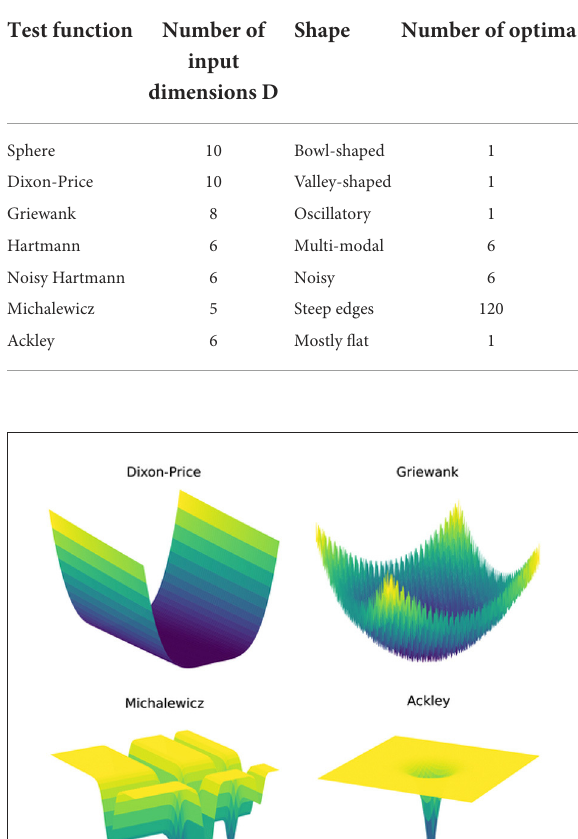
TABLE 1 Overview of the seven synthetic test functions.